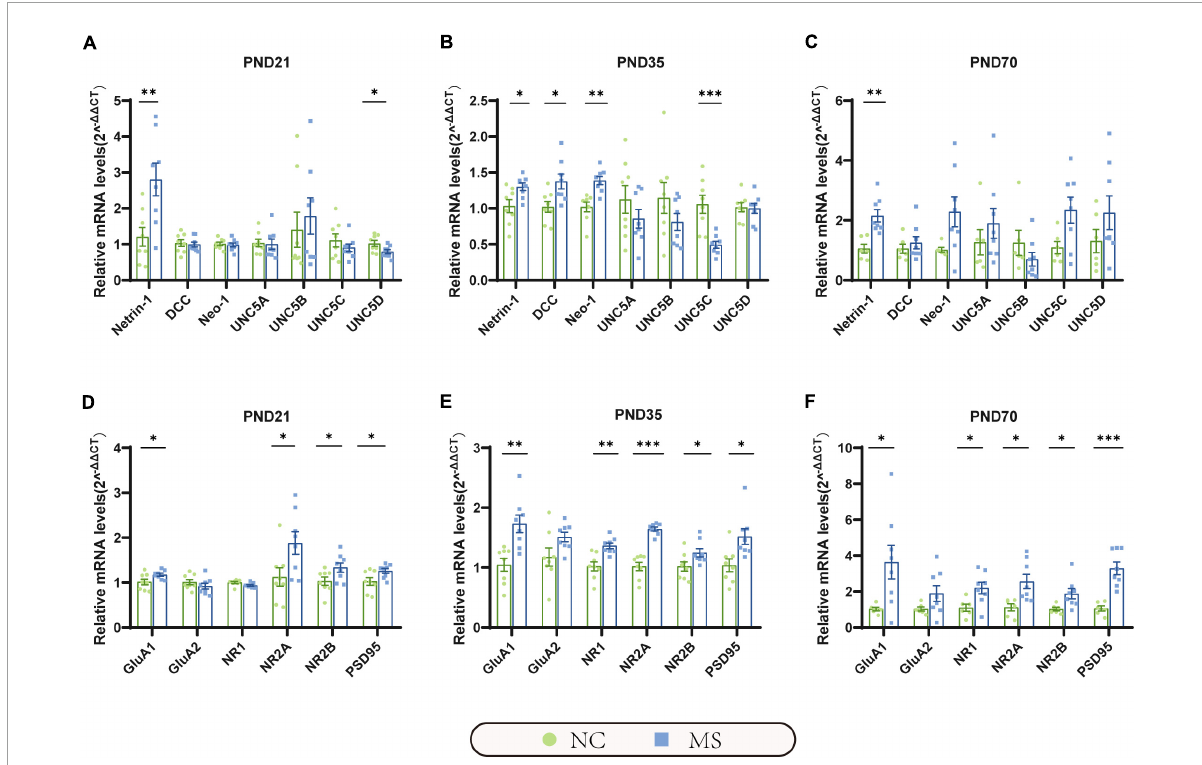
FIGURE5 The mRNA expression of Netrin-1 and GluA1 were significantly increased in the hippocampus in MS rats of three different age periods. (A) On PND21, the mRNA expression of Netrin-1 was significantly increased, but its receptor uncoordinated (UNC5D) was significantly decreased. (B) On PND35, the mRNA expression of Netrin-1, and its receptor DCC, neogenin-1 (Neo-1) were significantly increased, but UNC5C was significantly decreased. (C) On PND70, the mRNA expression of Netrin-1 was significantly increased, but its relative receptors showed no significant upregulation. (D–F) GluA1, NR2A, NR2B, and postsynaptic density 95 (PSD95) were significantly increased in all three MS groups. Besides, NR1 was found upregulated in MS rats on PND35 (E) and PND70 (F) . On PND21: NC, n = 8; MS, n = 8. On PND35: NC, n = 8; MS, n = 8. On PND70: NC, n = 6; MS, n = 8. All data were given as mean ± SEM. ∗ P < 0.05, ∗∗ P < 0.01, ∗∗∗ P < 0.001, two-tailed unpaired Student’s t